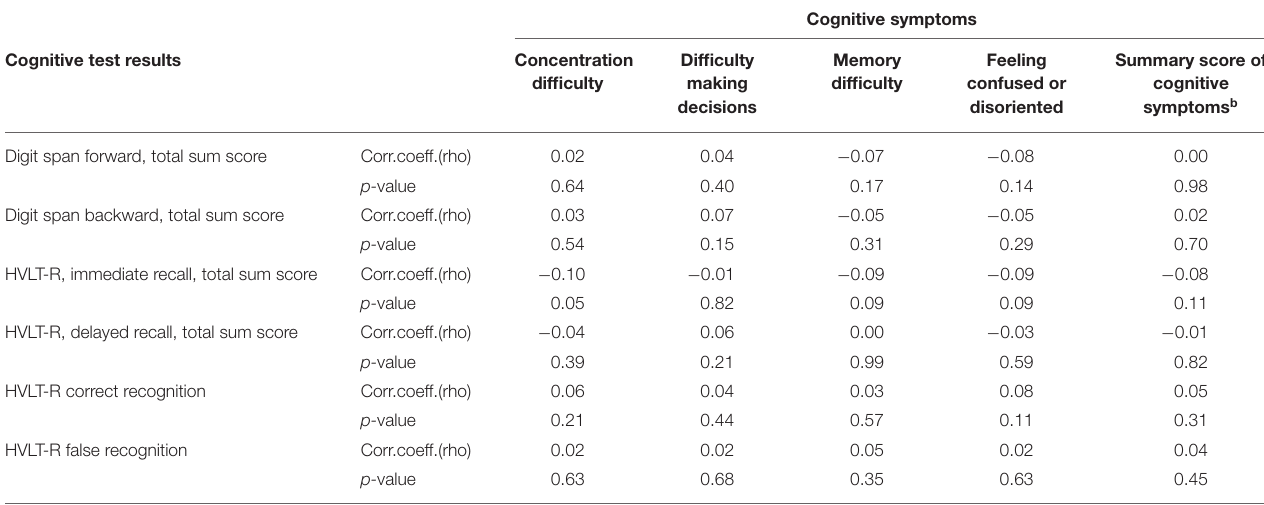
TABLE 4 | Correlation (Spearman’s rho) between cognitive symptoms and cognitive test results within the COVID-19 group a .